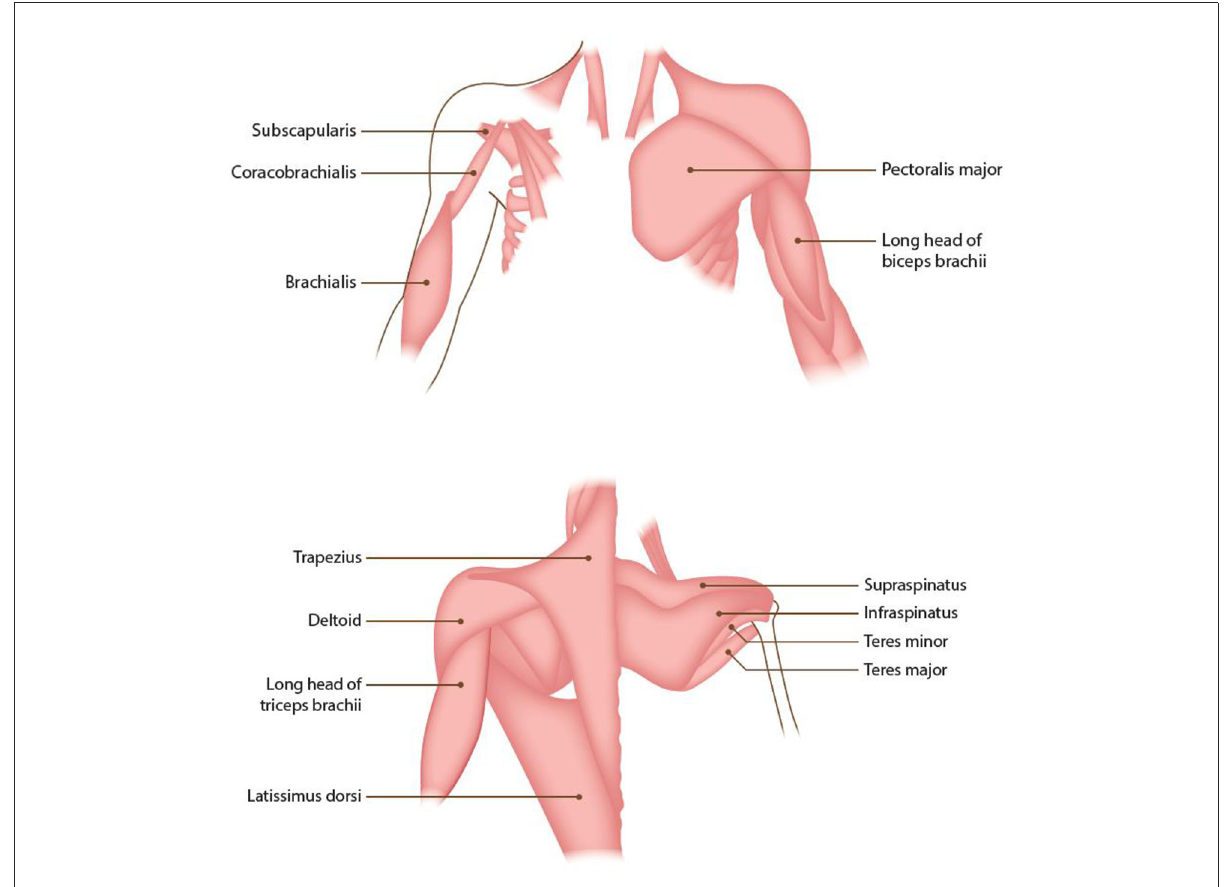
FIGURE2 Anatomy of the shoulder muscles.